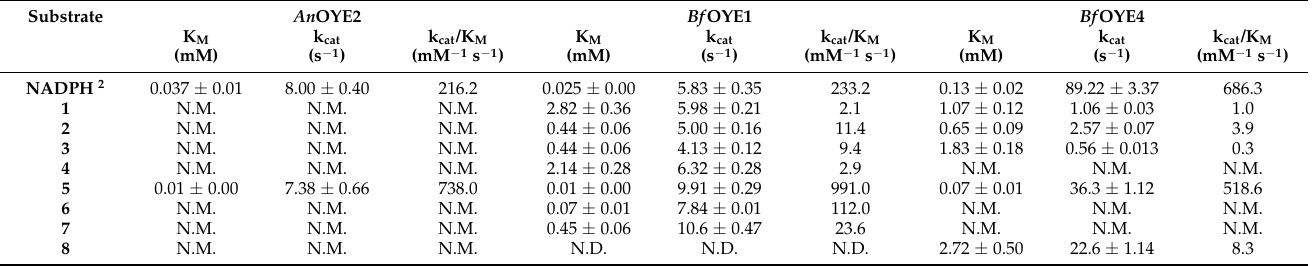
Table 2. Steady state kinetic parameters of An OYE2, Bf OYE1, and Bf OYE4 1